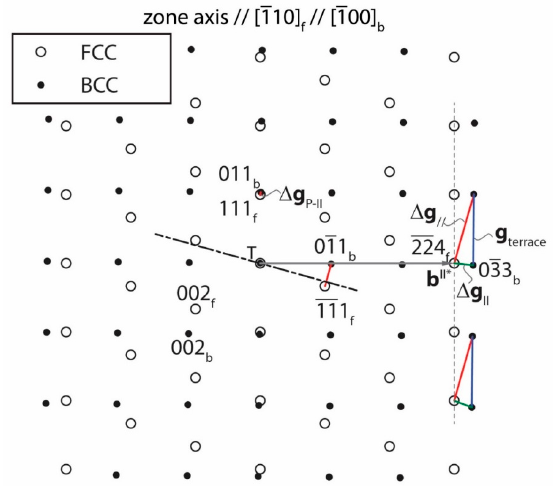
Figure 6. Identification of the characteristic triangles in reciprocal space based on the OR in Figure 4b. Note that all the red Δ g vectors are parallel to Δ g P-II and normal to the interface.